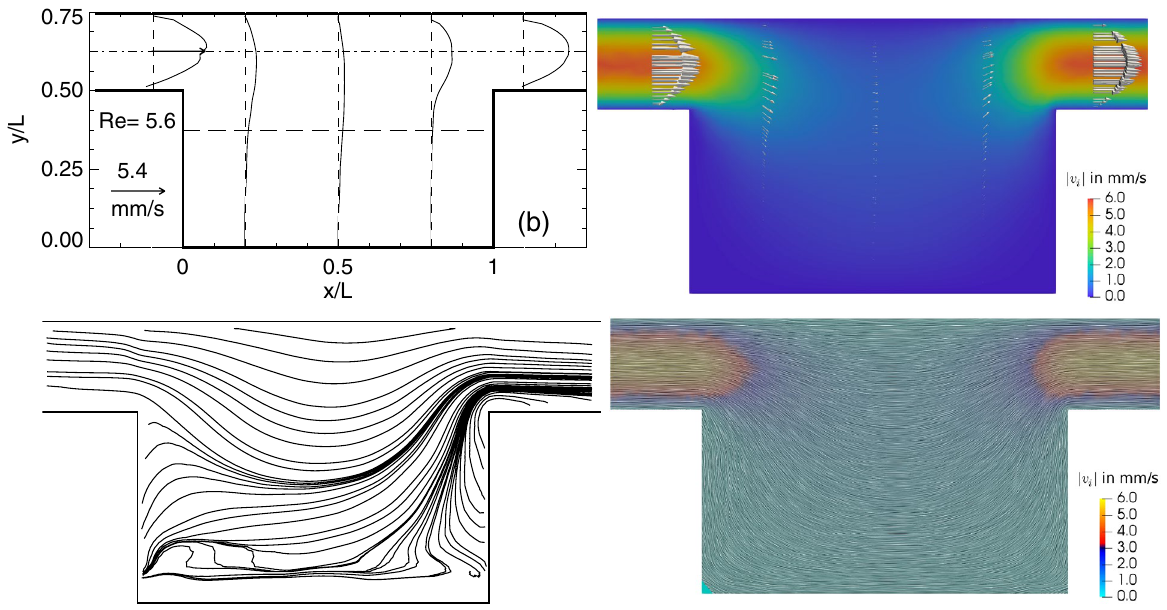
Fig. 7 Comparison of measurement and calculations: Case (b) PIV left column and CFD right column. Selected velocity profiles (top row) and streamlines (bottom row) are presented